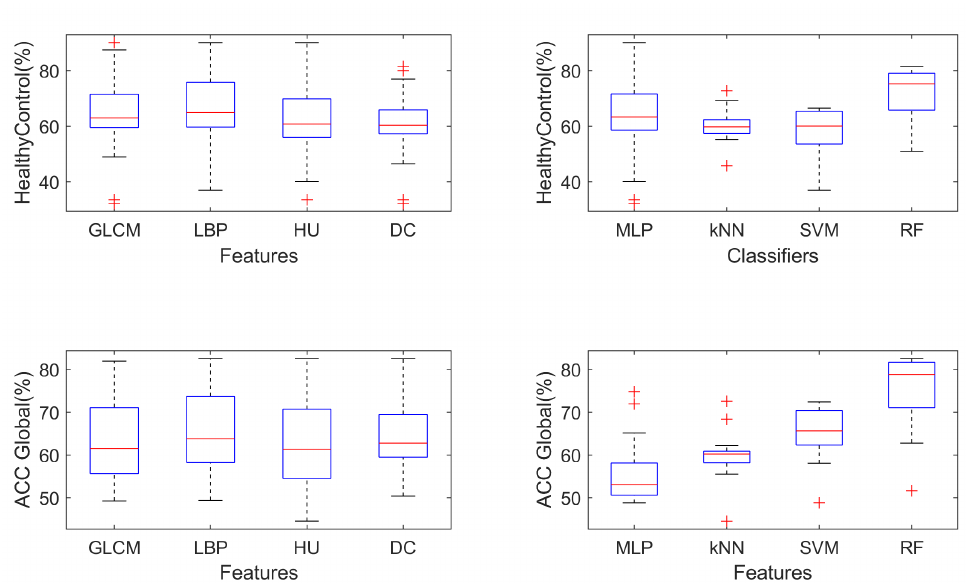
Figure 5. Comparison of mean values of performance measures for various combinations of feature sets and classifiers.